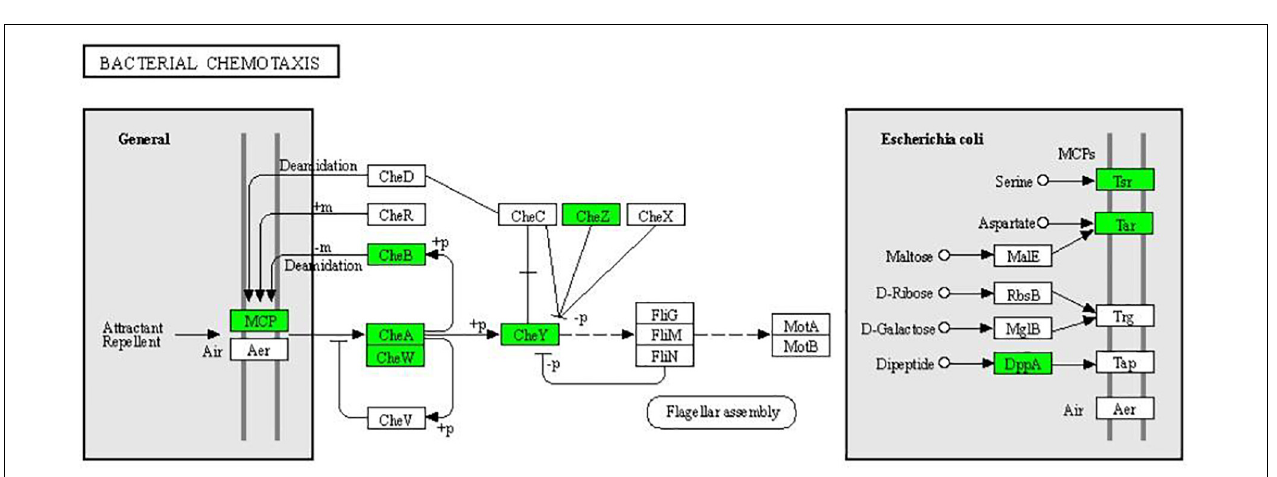
FIGURE 8 | Significantly enriched KEGG pathway: Bacterial chemotaxis (from the KEGG database, green frames represent downregulation, and red frames represent